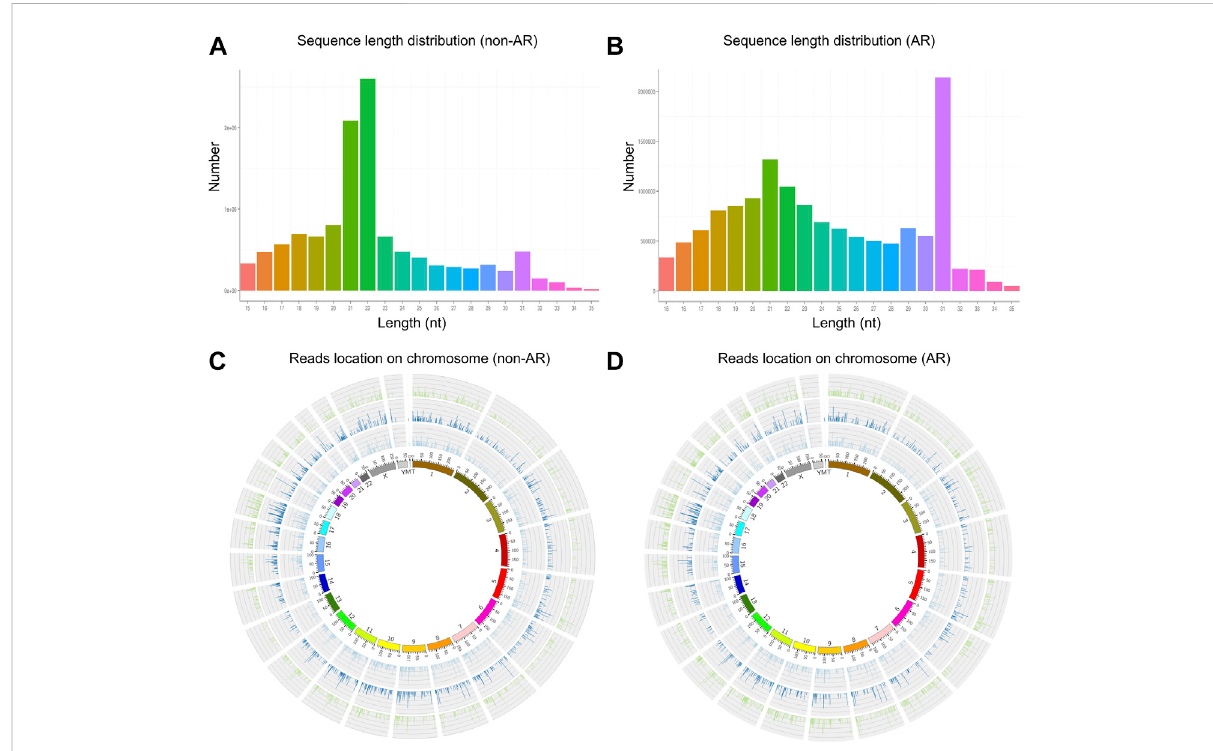
FIGURE 3 Thelengthdistributionofthecleanreadssequenceandlocationofcleanreadsoneachchromosome. (A,C) non-ARpatients. (B,D) ARpatients.